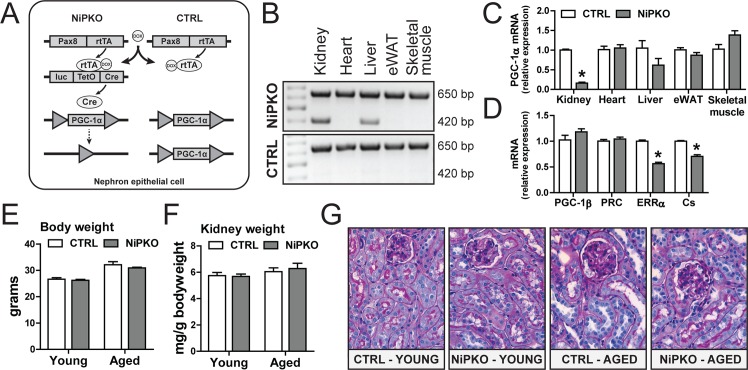
Kidney-specific inactivation of PGC-1α in NiPKO mice.(A) Nephron-specific inducible PGC-1α knockout (NiPKO) mice were generated by crossing transgenic Pax8rtTA-(tetO-cre)-LC1 mice with mice having two floxed PGC-1α alleles (PGC-1αfl/fl). Knockout was induced through doxycycline administration for 14 days. (B) Representative recombination PCR for PGC- 1α on DNA extracted from kidney, heart, liver, epididymal white adipose tissue (eWAT) and skeletal muscle. The amplified products for the wild-type and knockout alleles are approximately 650 bp and 420 bp, respectively. (C) mRNA levels of PGC-1α in kidney, heart, liver, eWAT and skeletal muscle, normalized to eukaryotic elongation factor 2 (eEF2) mRNA levels (n = 5–7). (D) mRNA levels of indicated genes in kidney normalized to eEF2 mRNA levels (n = 7–8). (E) Body weight and (F) average kidney weight normalized to body weight of mice at 1 and 12 months after doxycycline administration (n = 6–16). (G) Representative pictures of kidney histology at 1 and 12 months after doxycycline administration (n = 3). Error bars represent mean ±SEM. Significant differences (p-value <0.05) between genotypes are indicated by an asterisk (*).